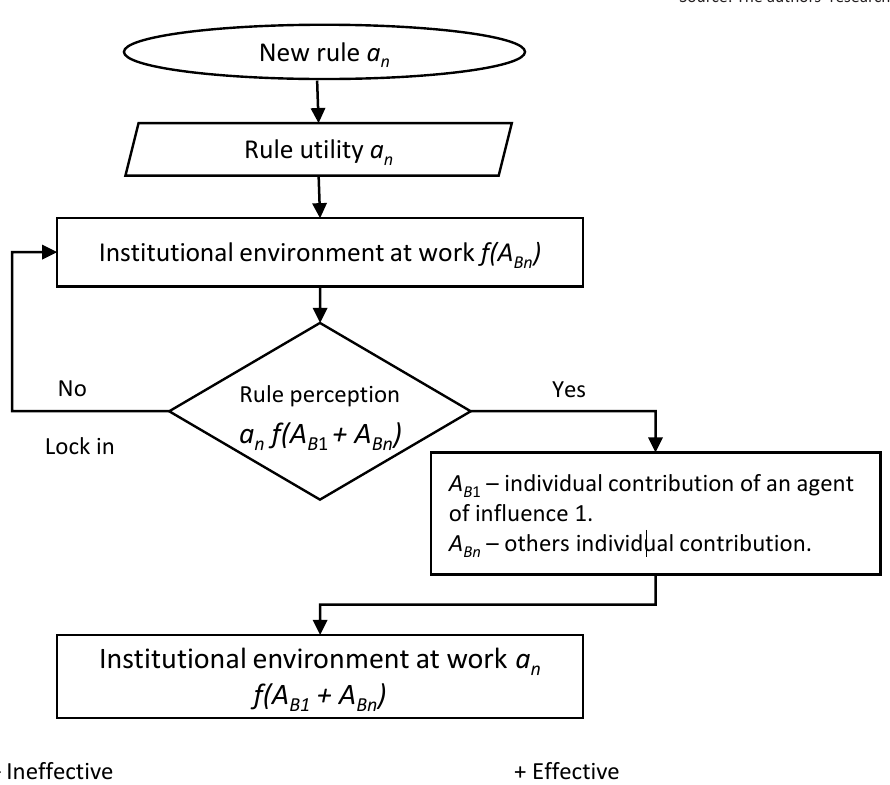
Figure 2. Algorithm of a new rule